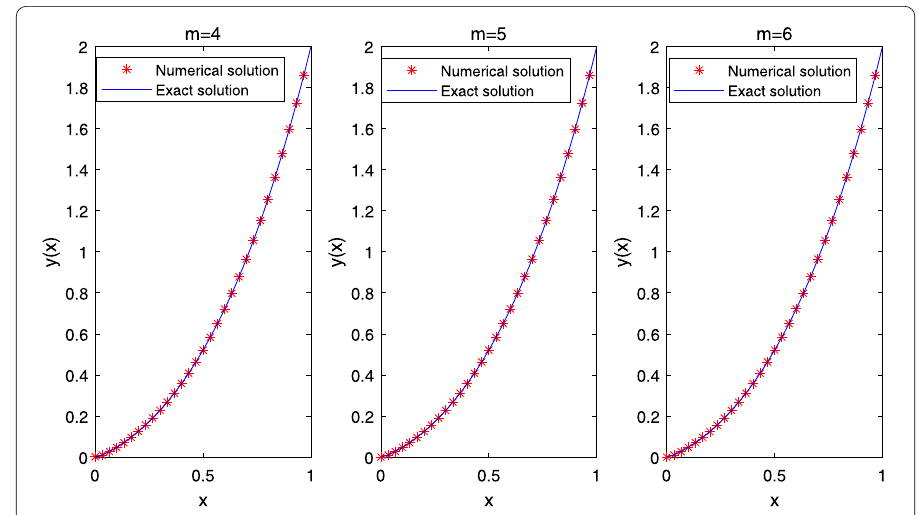
Figure 1 Comparisons of numerical solutions and exact solution of Example 2 for different m